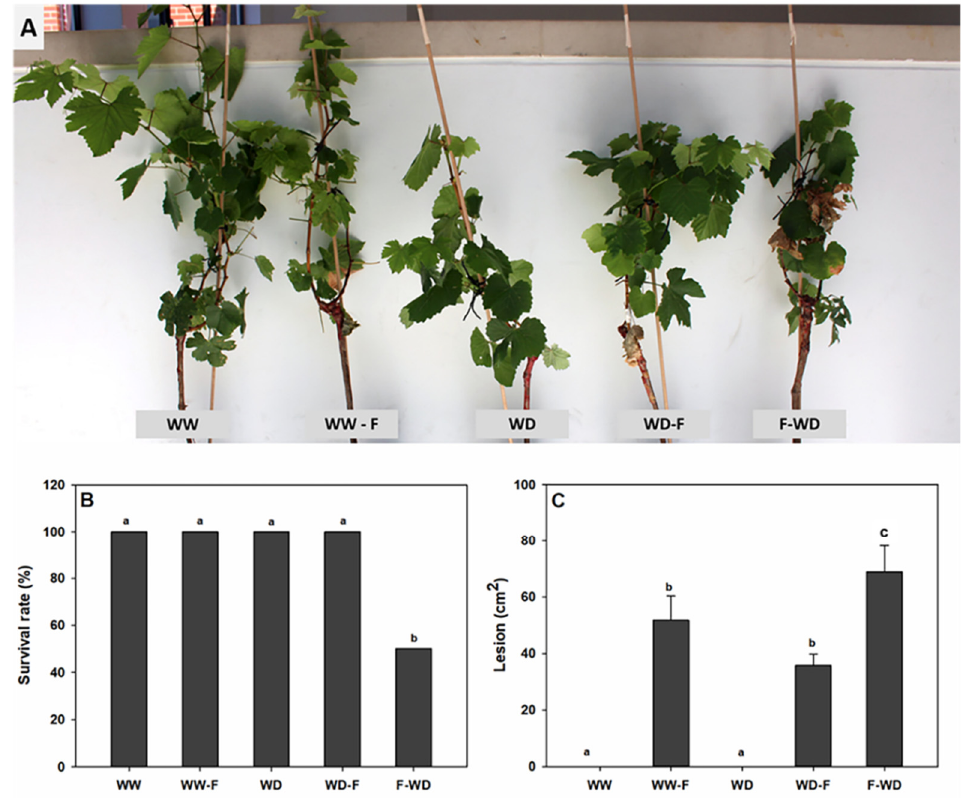
Figure 1. ( A ) External disease symptoms, ( B ) survival rate (%), and ( C ) internal stem lesion (cm 2 ) of grapevines exposed to WW (well-watered control); WW-F (well-watered fungal inoculation); WD (water deficit); F-WD (inoculation before water deficit); WD-F (inoculation after water deficit). Different lowercase letters indicate significant differences among the five treated groups ( p ≤ 0.05).